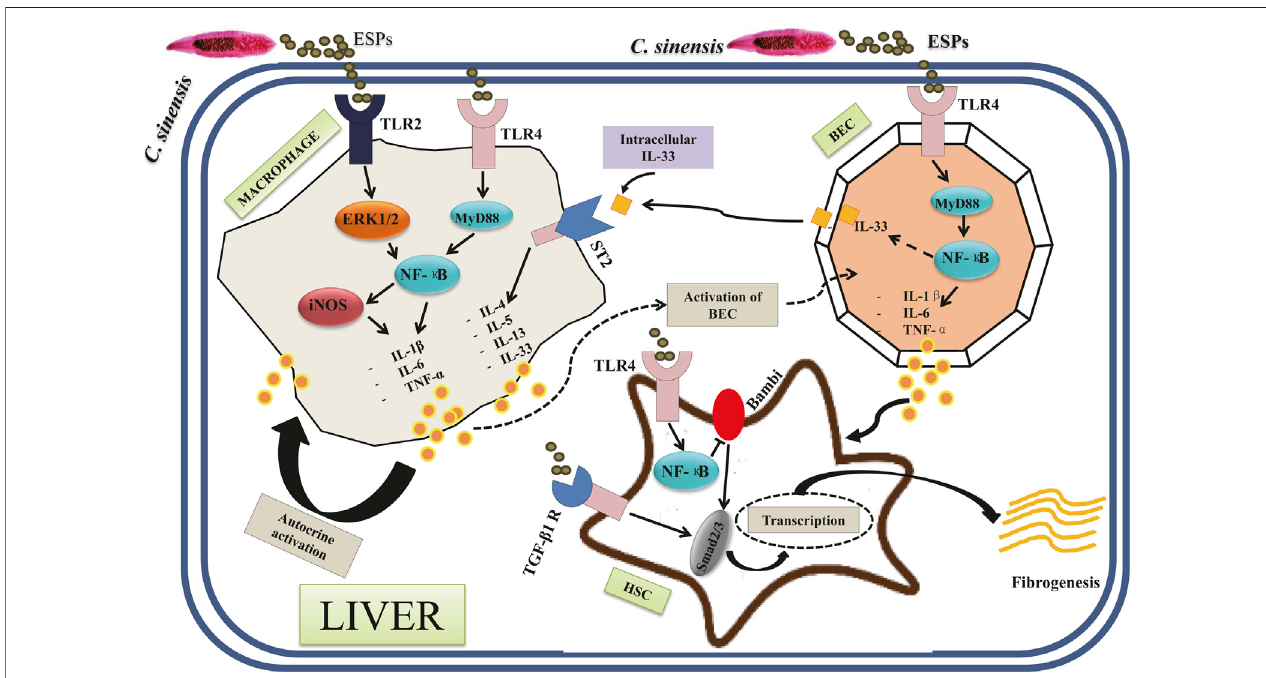
FIGURE 3 | Different types of signaling pathways involved in the pathogenesis of Clonorchis sinensis infection: The interaction between the parasite and its host results intheactivationofseveralsignaling pathways.TheactivationofTLR2and TLR4inmacrophages by C.sinensis ESPs leadsviaERK1/2 and MyD88, respectively, to the activation ofNF- κ B. The transcription leads tothe production ofpro-in fl ammatory cytokines (IL-1 β , IL-6, and TNF- α ).The activation of theTLR4 of cholangiocytes also leads to the production of the pro-in fl ammatory cytokines (IL-1 β , IL-6, and TNF- α ) via the MyD88 and NF- κ B signaling pathways. Another signaling pathway involvestheTGF- β 1receptorinhepaticstellatecells.Inthissignalingpathway,theactivationofTGF- β 1Rby C.sinensis ESPsleadstotheactivationofSmad2/3followed by transcription with an increase in cell growth and survival. In hepatic stellate cells, the activation of TLR4 also leads to the activation of NF- κ B and Smad2/3 with an increase in cell growth and